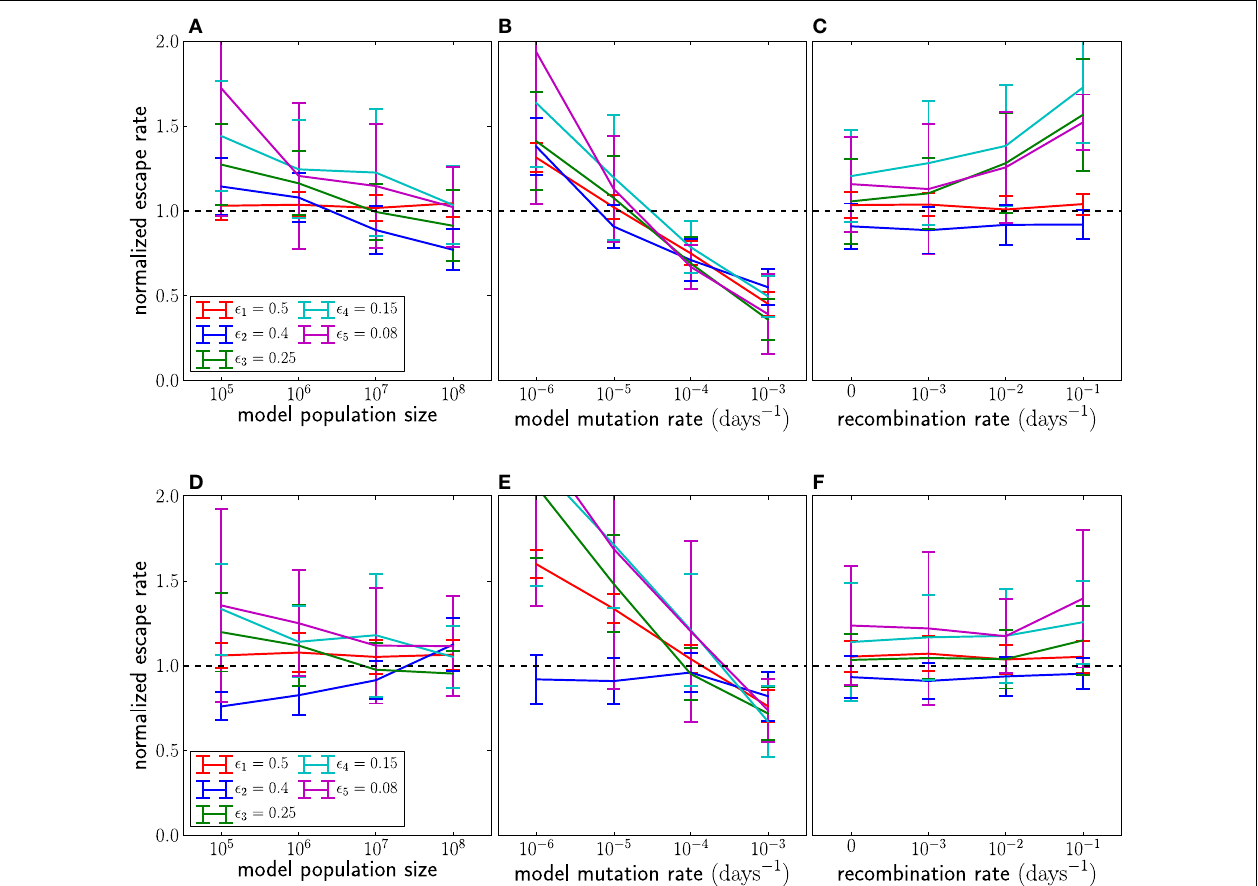
estimates of escape rates are too low. Note that assuming the correct rates [ µ = 10 − 5 in (B) and µ = 10 − 4 in (F) ] results in unbiased estimates. (C,F) If the population recombines, the actual seed times are smaller than those estimated by the fitting routine.To compensate for the shorter time interval during which the escape variant rises, the estimates of escape rates are larger than the actual escape rates, at least at low mutation rates. For high mutation rates, recombination is less important because additional mutations are more efficient at producing multiple mutants than recombination. Mean and standard deviation at each point are calculated from 100 independent